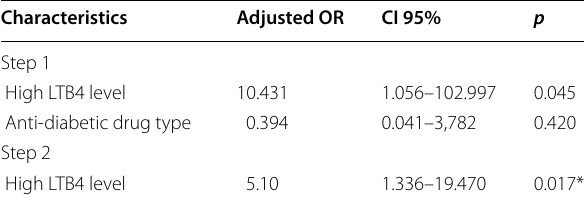
Table 4 Multivariate logistic regression